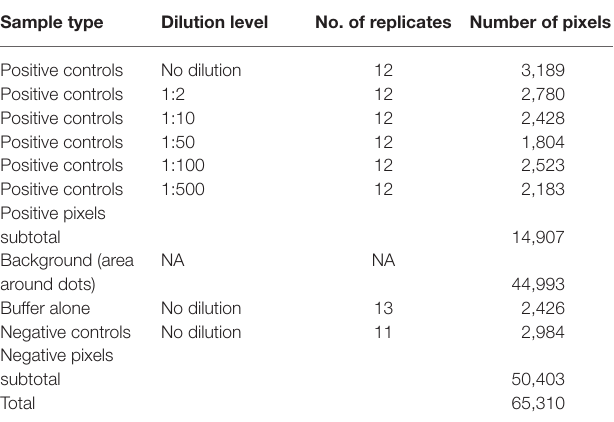
TABLE 1 | Relative frequencies of pixel categories of the prototypic dataset by infection status. Sample type